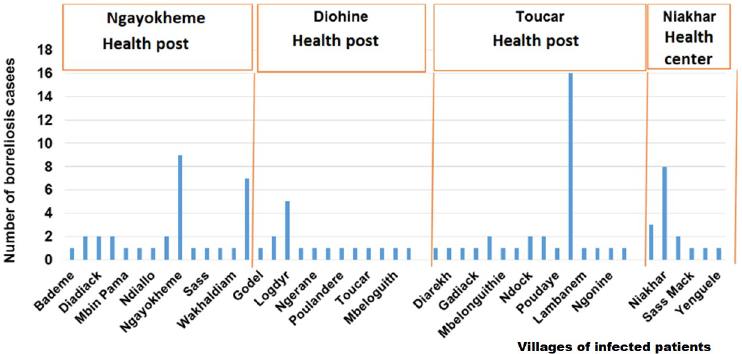
Fig 6. Annual distribution of diagnosed borreliosis cases by village, health post and the health center in the Niakhar district.